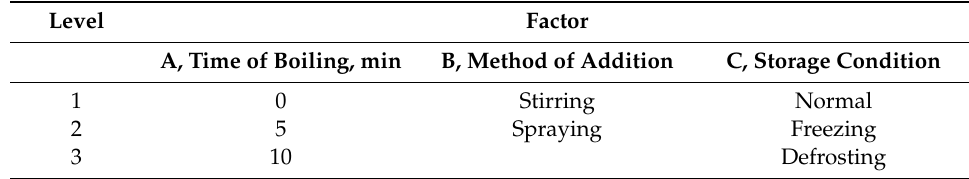
Table 1. Orthogonal tests for the factorial experiment of developing food waste as a liquid-state addition to non-wood pellets from residual biomass from the distillation of cellulosic